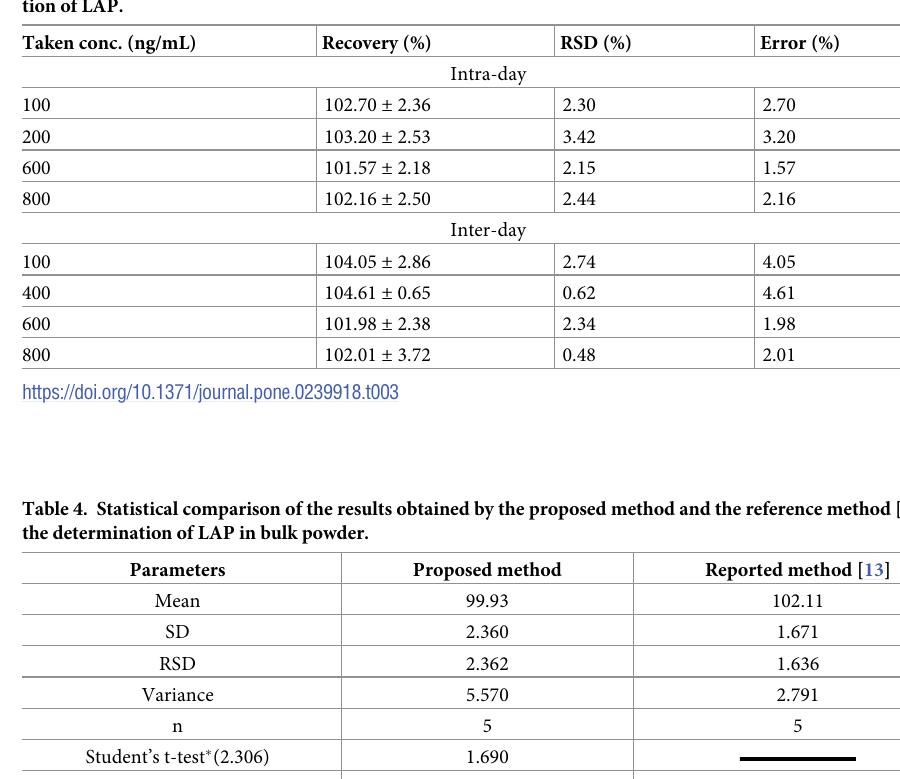
� Figures in parenthesis are the corresponding tabulated values at p = 0.05.